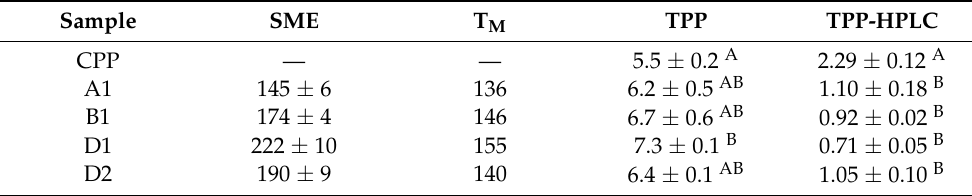
Table 8. Polyphenols contents of chokeberry pomace powder (CPP) and samples after extrusion processing (g/100 g dm, mean ± SD, n = 2) at water contents of 13% (A1, B1, and D1) and 23% (D2), respectively. SME, specific mechanical energy (Whkg − 1 ); T M , material temperature ( ◦ C); TPP, total polyphenols contents analyzed by the Folin–Ciocalteu test; TPP-HPLC, total polyphenols contents calculated as the sum of monomeric anthocyanins, phenolic acids, and flavonols. Sample SME T M TPP CPP